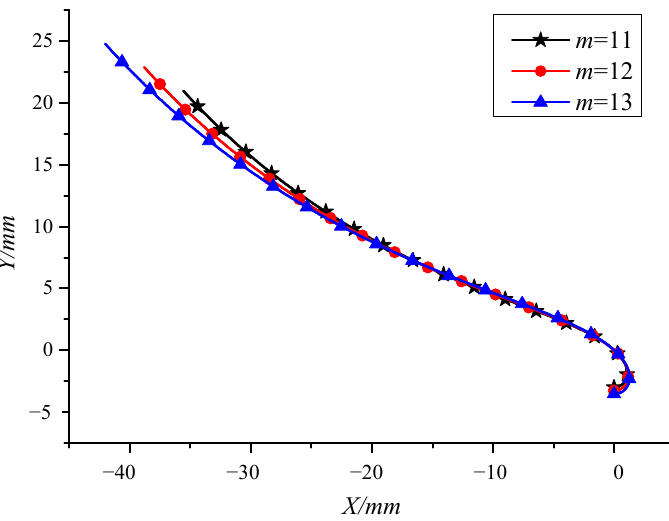
Figure 15. The influence law of m on the line of action. The influence law of the diameter coefficient of roller pin c f on the line of action is shown in Figure 16. It can be seen that the change of c f has a certain influence on the start and end points of the line of action. The ordinate of the starting point of the line of action decreases with the increase of c f , the abscissa of the end point of the line of action increases with the increase of c f , and the length of the line of action increases with the increase of c f